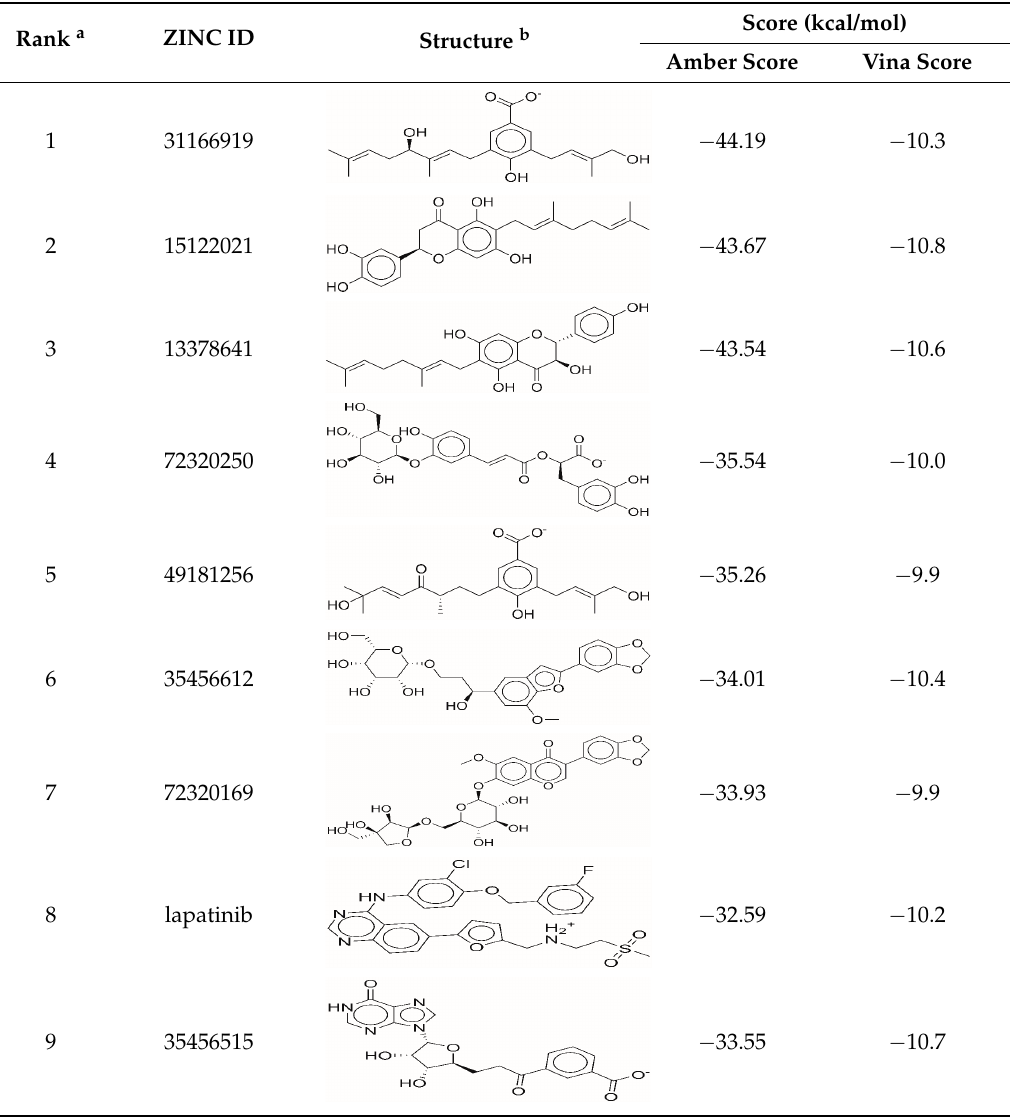
Table 1. The results of virtual screening and structures of common top-score compounds.